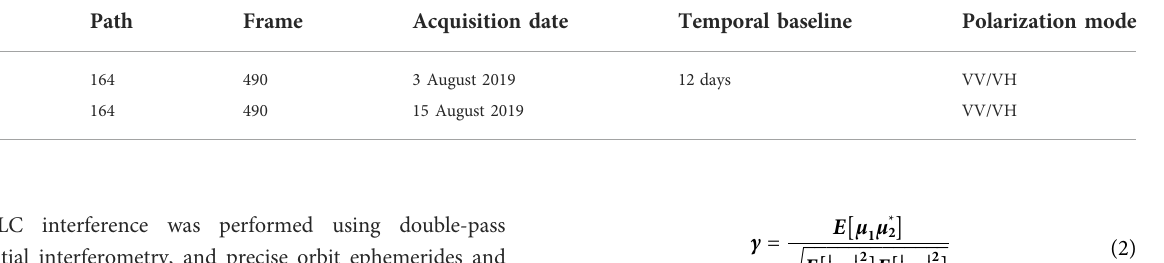
TABLE 3 Sentinel-1A images covering the validation area